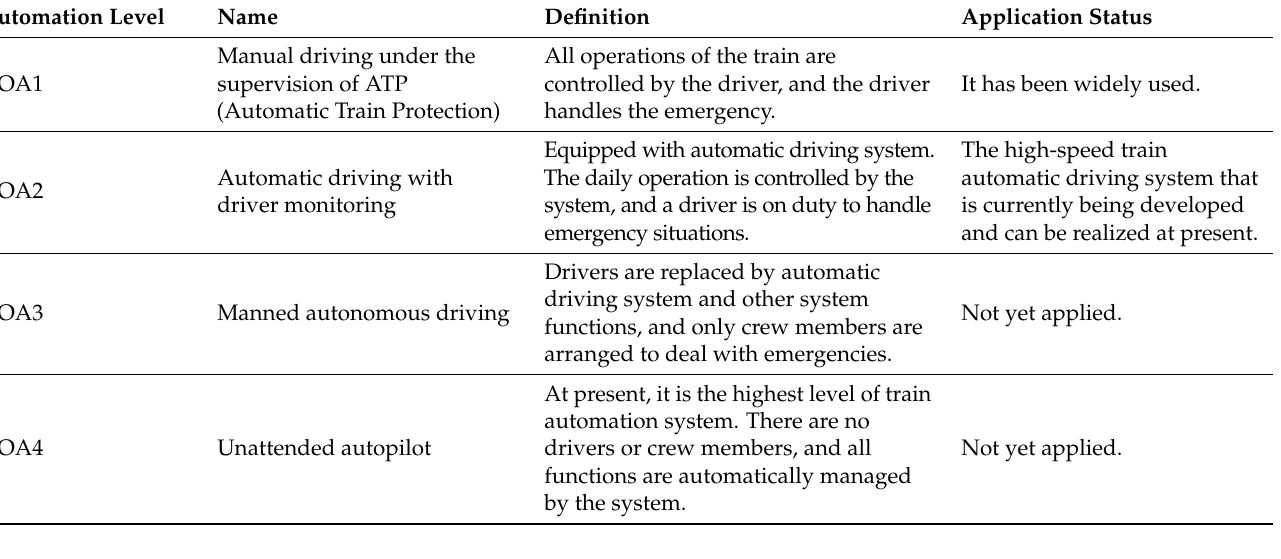
Table 1. Automation level of high-speed train automatic driving system.